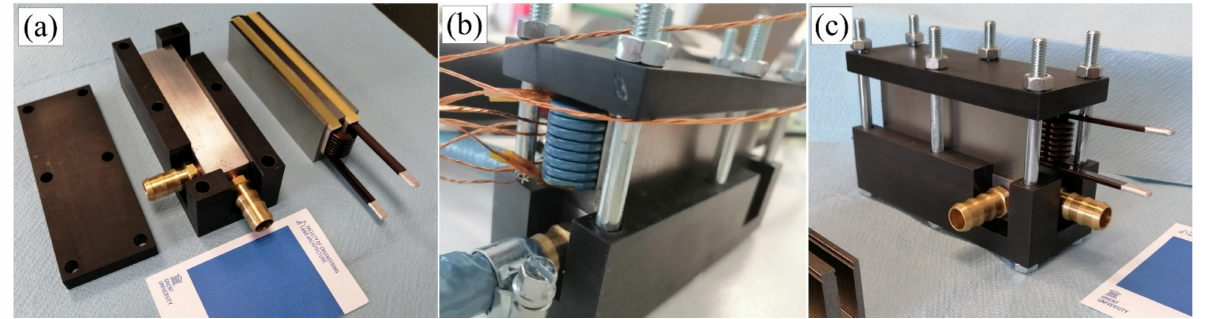
Figure 9. Cooling jacket used to control the sample temperature: ( a ) cooling jacket components; ( b ) assembly with a flat copper coil; ( c ) assembly with a flat aluminum